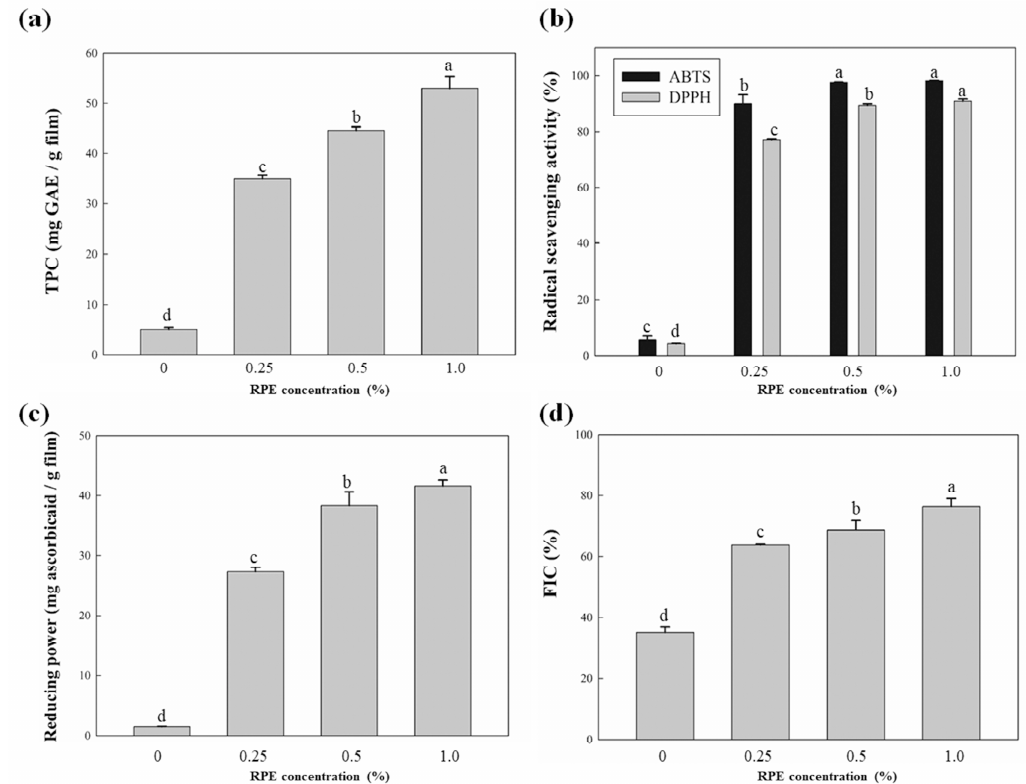
Figure 4. Antioxidant activities of the CJP films containing different concentrations of RPE: ( a ) TPC; ( b ) radical scavenging activities; ( c ) reducing power; ( d ) FIC.